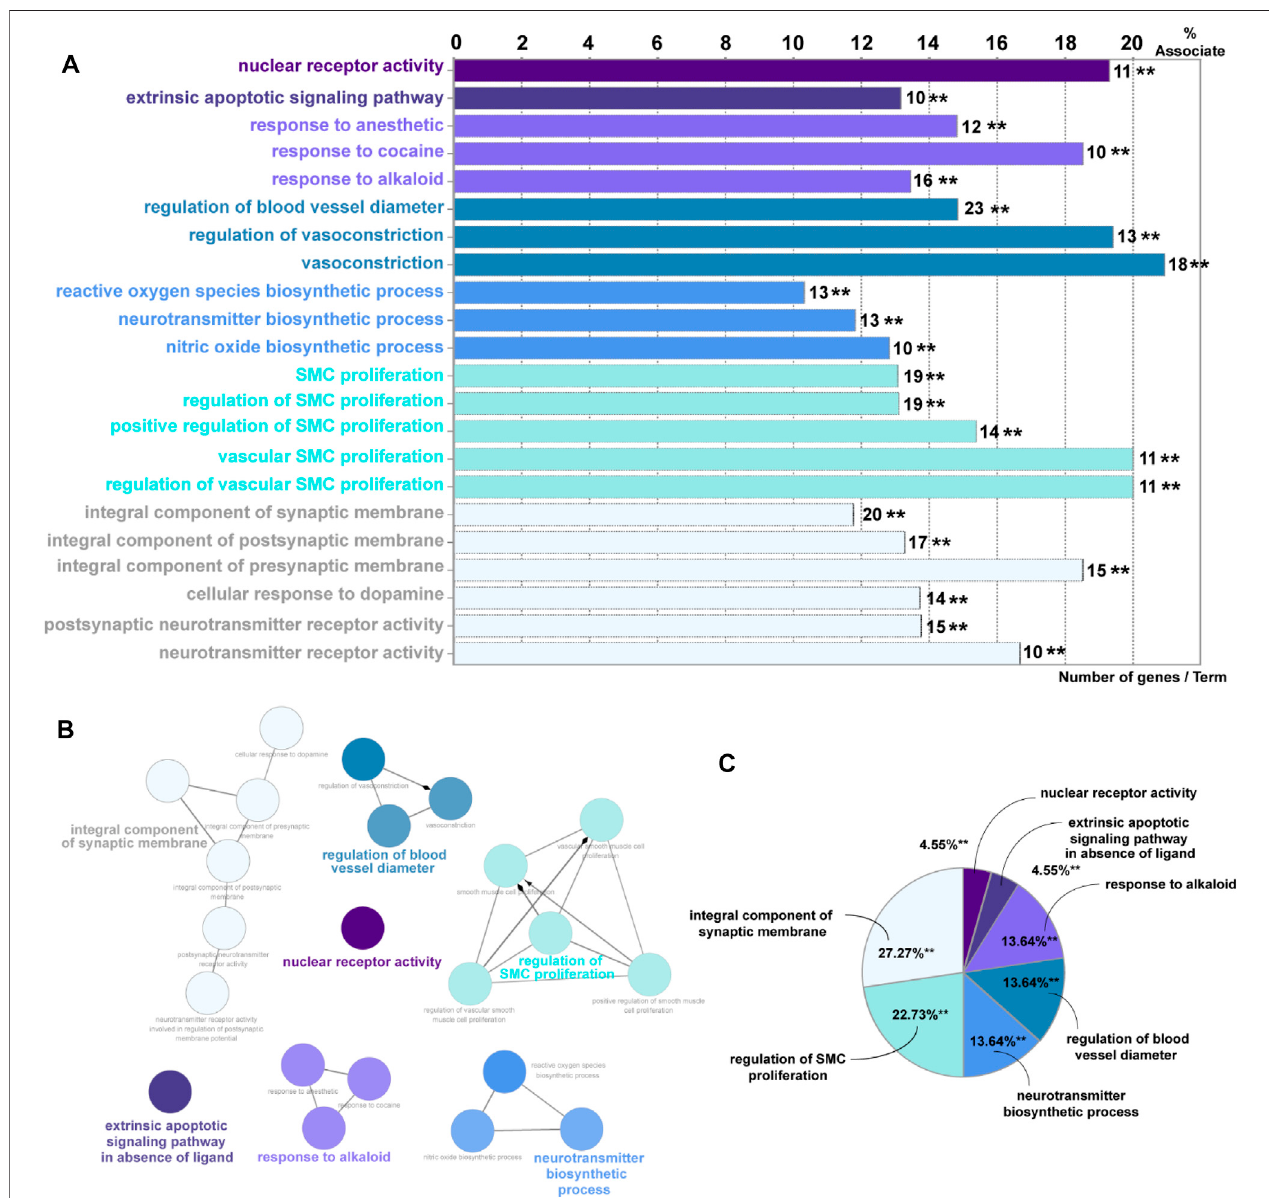
FIGURE 1 | GO enrichment analysis of potential targets and biological networks involved in Salvia miltiorrhiza treating AKI. (A) Bar chart presenting the percentage of genes involved in different biological functions, and the numbers of related genes in these signaling pathways are intersected. (B) Brief view of the 7 GO pathways; all pathways have a p -value of < 0.01. (C) GOpathwaysare presented inthe pie chart.Detailedinformation couldbefoundinthe supplementary fi les: SupplementaryTable S1 : eligible active ingredients; Supplementary Table S2 : target proteins involved in the networks; Supplementary Table S3 : signi fi cant target genes related to the proteins; Supplementary Table S4 , Supplementary Figure S1 : intersection genes of Salvia miltiorrhiza and AKI; Supplementary Figure S2 : the KEGG pathways.